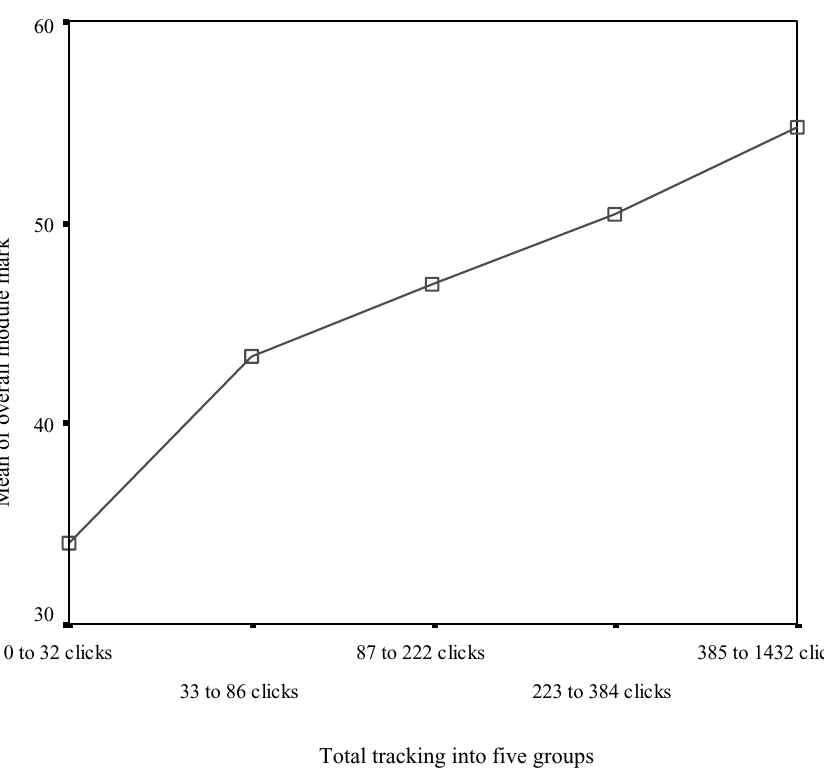
Figure 1. Correlation between online behaviour and assessment performance (MOB